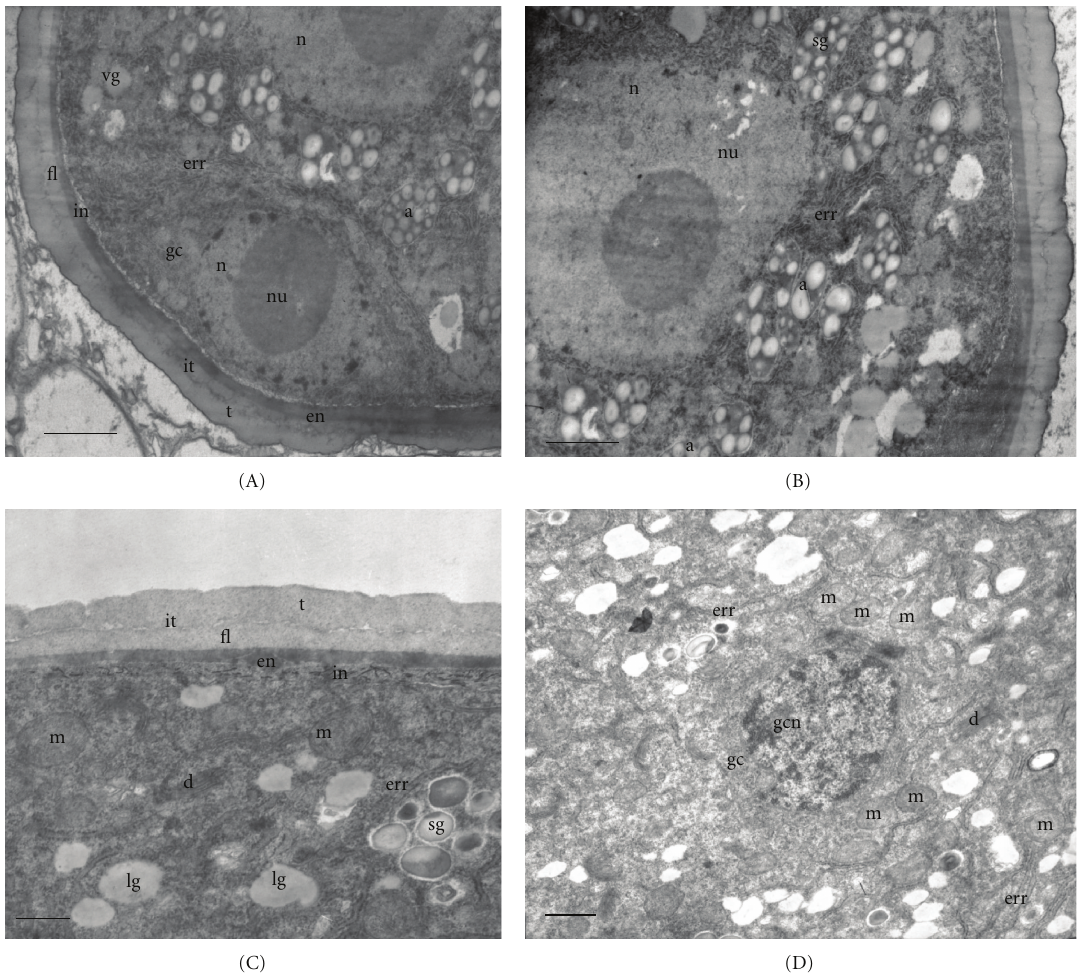
Figure 5: (A)-(B) Stage 4: young pollen grain of Colletia paradoxa. (C)-(D) Stage 5: mature pollen grain of Discaria americana. (A) Vegetative cell (VC), with endoplasmic reticulum of rough type (err), amyloplasts (a), and its nucleus (n) and nucleolus (nu); generative cell (GC) with its nucleus (n) and nucleolus (nu); tapetal cells (tc) and orbicules (o). (B) Details of the vegetative cell. (C) Generative cell with starch grains (sg), lipid globules, mitochondria (m), dictyosomes (d), endoplasmic reticulum of rough type (err). (D) Generative cell (gc) and its nucleus (gcn). Other references: t: tectum, it: infratectum, ft: foot layer, en: endexine, in: intine. Scale bar: (A)-(B) 1.3 µ ; (C) 500nm; (D) 1 µ